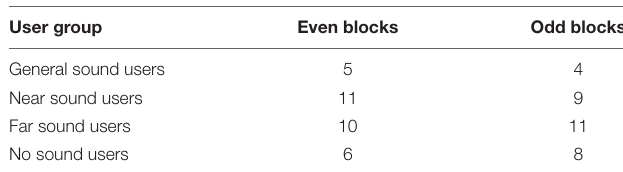
TABLE 1 | Number of participants for each sound user group based on even or odd blocks for group